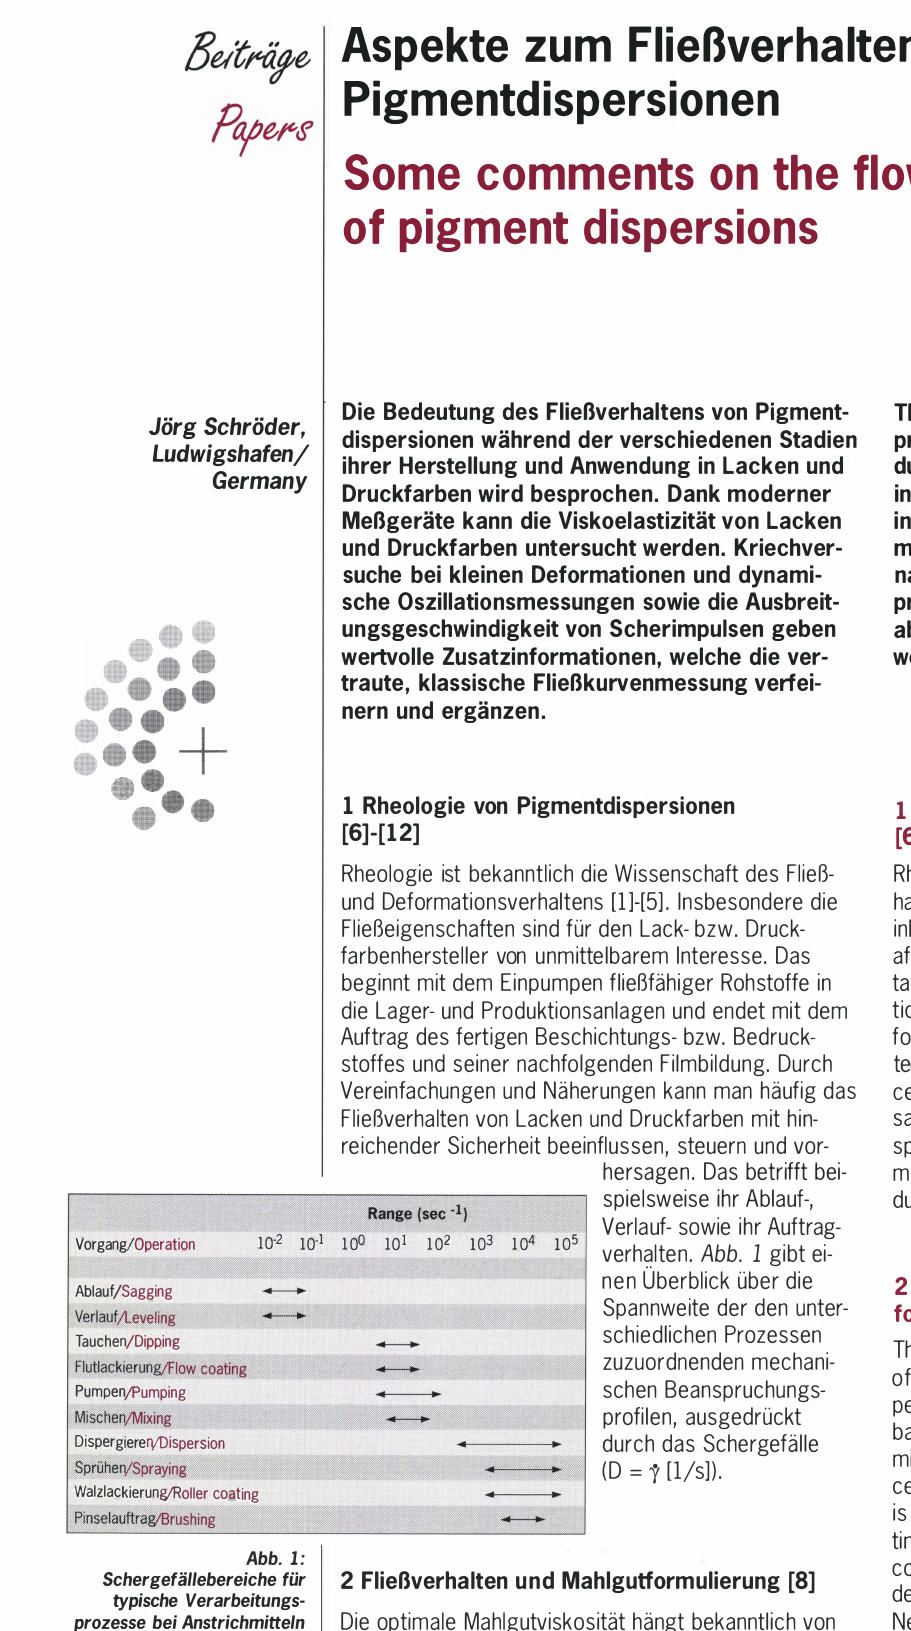
Fig. I: Approximate shear rate rangers for several common coating